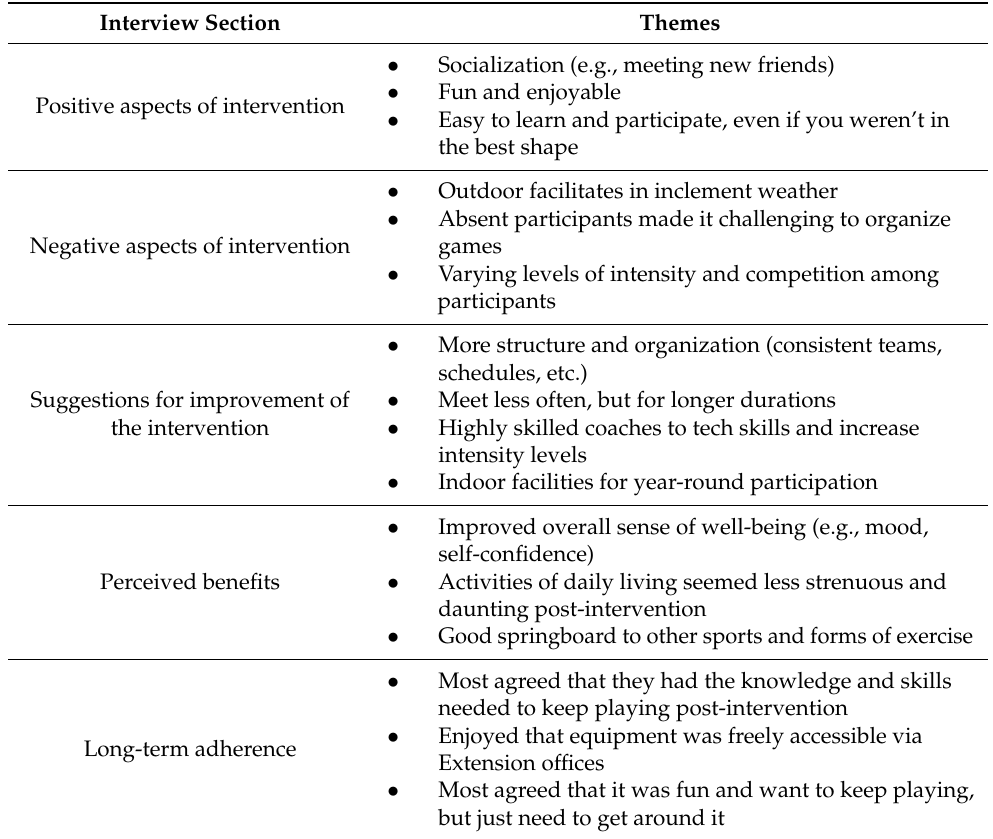
Table 4. Summary of key themes derived from qualitative interview